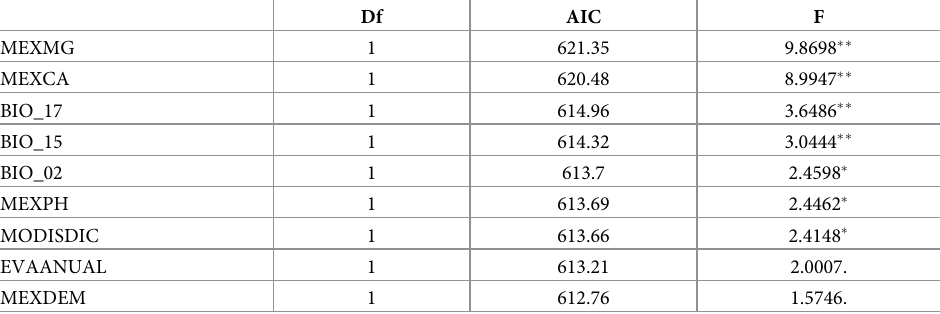
Table 1. Variables that constitute the most parsimonious model of redundancy